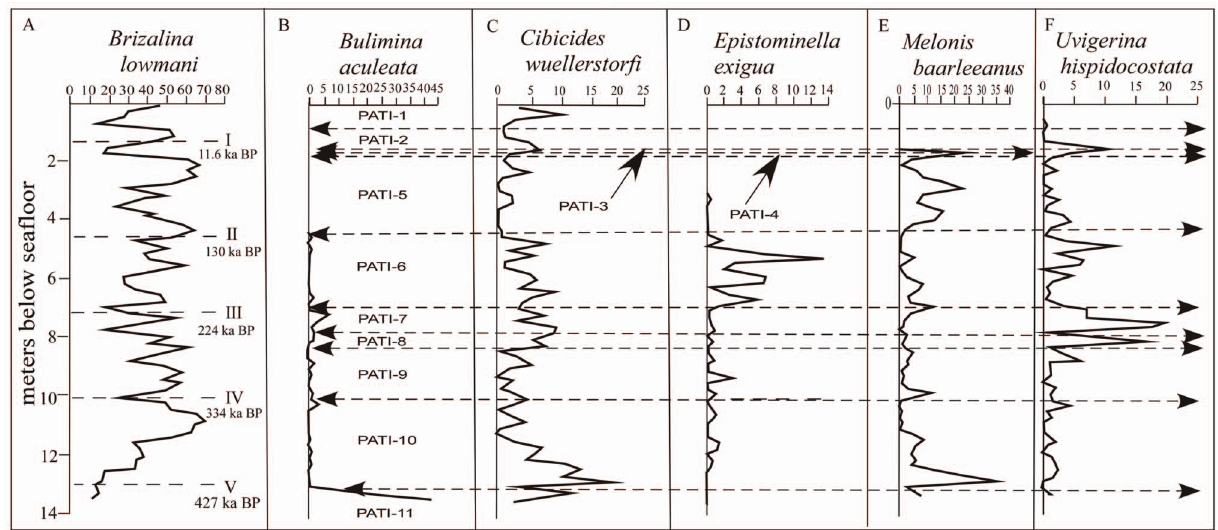
Figure 3. Percentage abundances of selected species in the Upper Quaternary of ODP Hole 994C, species presented in alphabetical order. A. Bulimina aculeata . B. Brizalina lowmani . C. Cibicides wuellerstorfi . D. Epistominella exigua . E. Melonis baarleeanus . F. Uvigerina hispidocostata . Dashed lines in A indicate positions of Terminations I – V, with ages in ka BP. Dashed lines in B – F indicate boundaries between PATIs 1 to 11. Terminations are indicated by Roman numerals in order of increasing age.